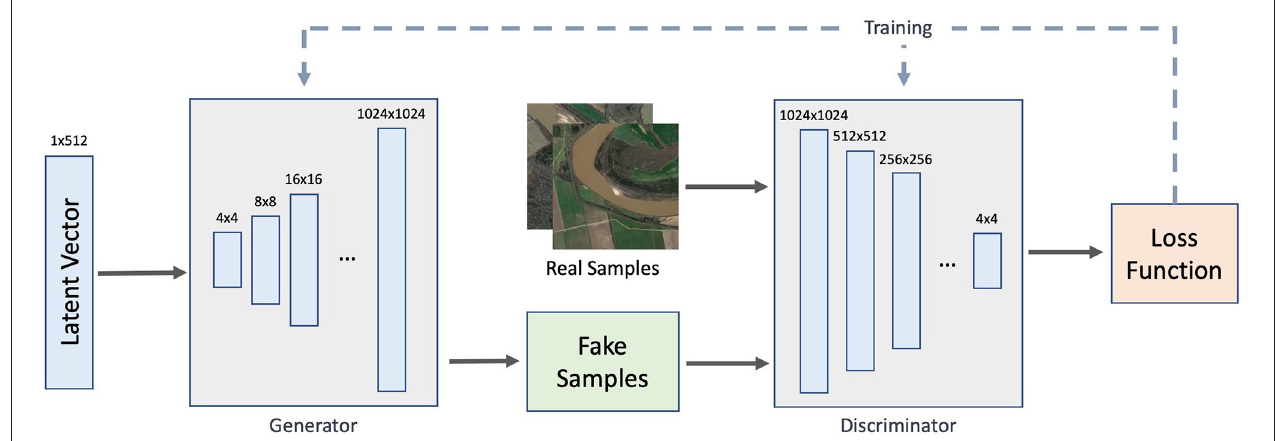
FIGURE 2 | PGGAN architecture for custom 1,024 × 1,024 satellite image